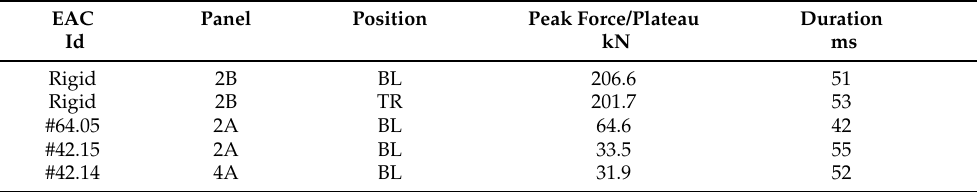
Table 5. Parameters of the experimental force–time curves.